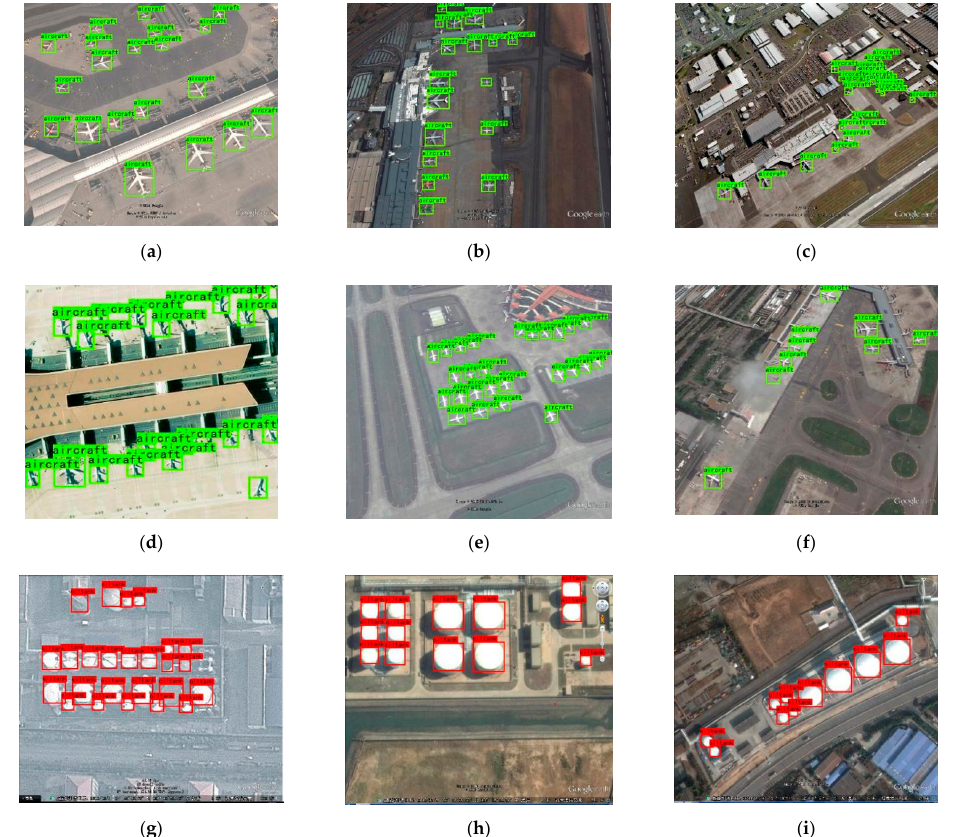
Figure 14. The detection results with the RSOD dataset. Figure 14.